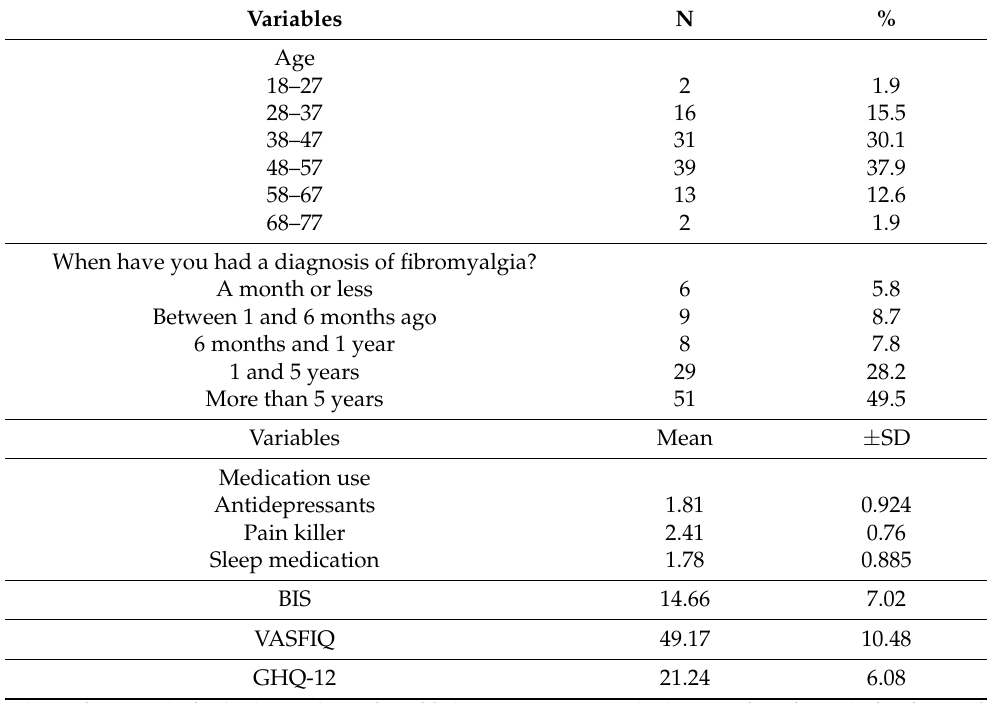
Table 1. Characteristics of the sample.